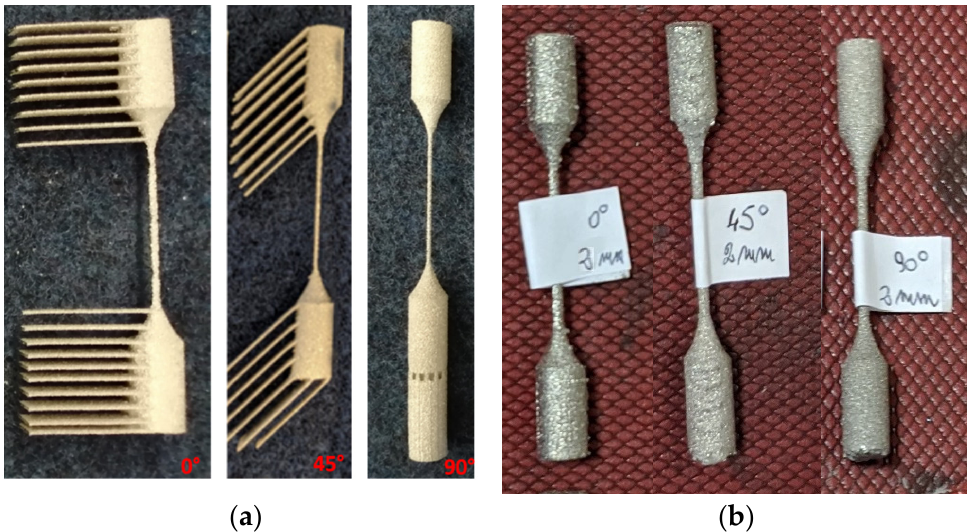
Figure 4. ( a ) Beam specimens before removing supports. ( b ) Beam specimens after removing supports.